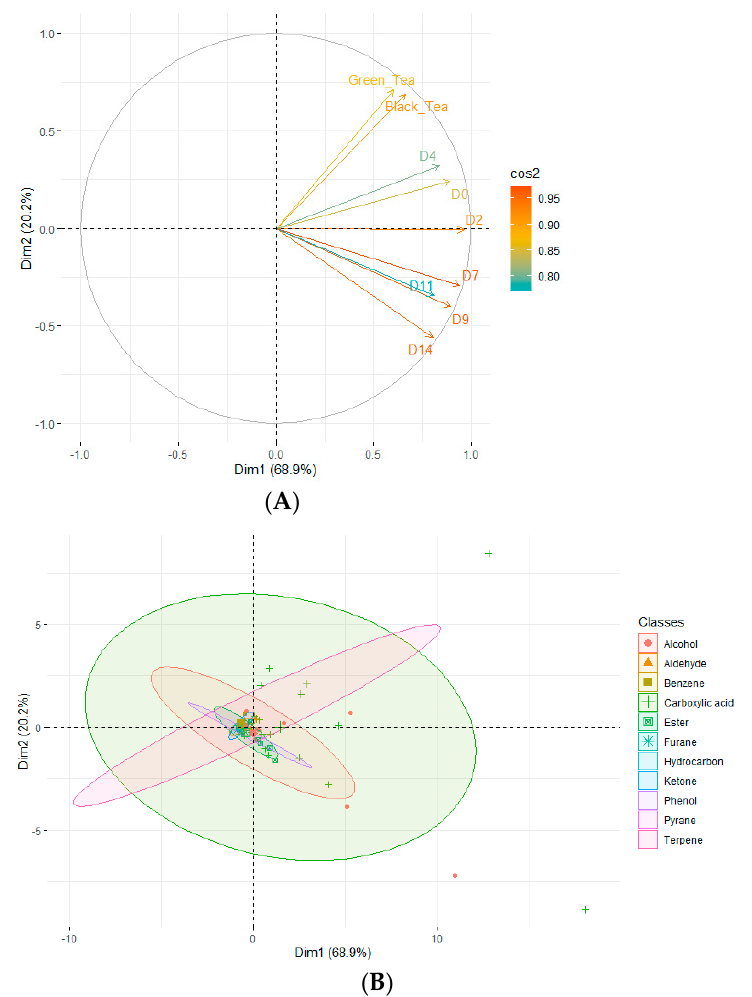
Figure 5. Principal component analysis (mean values for VOCs averaged across kombucha fermentation time (day)) plots of variables correlation (cos² color scale) ( A ) and individuals’ representation (ellipses corresponds to VOCs classes) ( B ) (labelled individuals are those best represented on the plan).